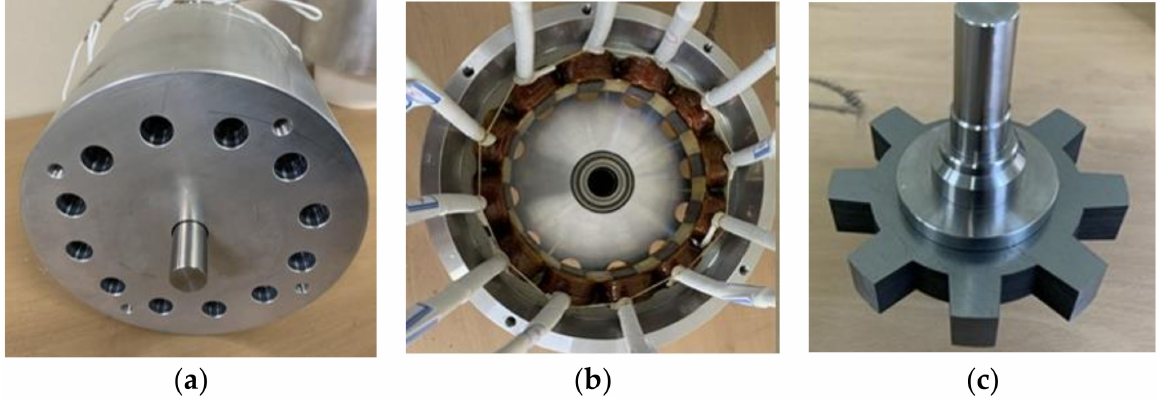
Figure 14. Prototype motor: ( a ) Assembled, ( b ) Stator, ( c ) Rotor.